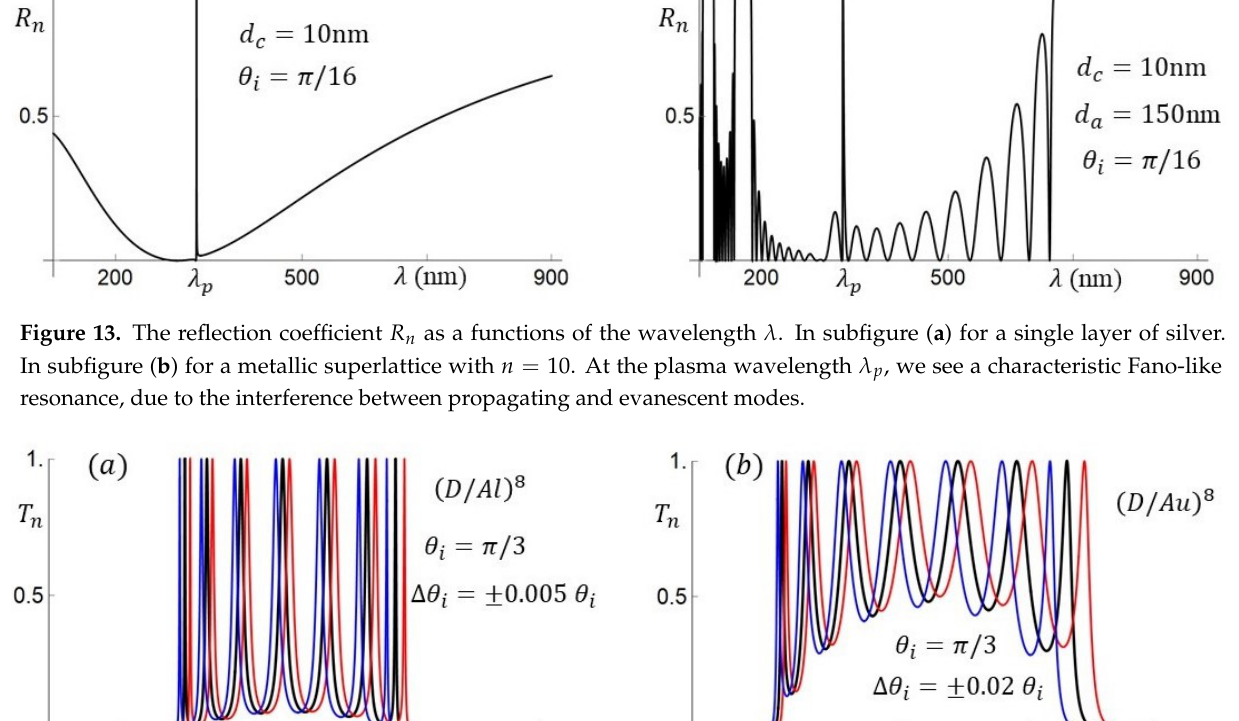
± 0.02 θ i = i for the